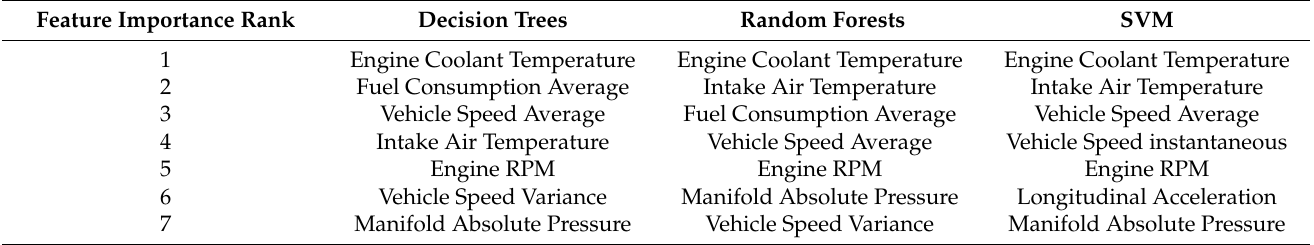
Table 4. Road surface conditions feature importance using the permutation feature importance approach.